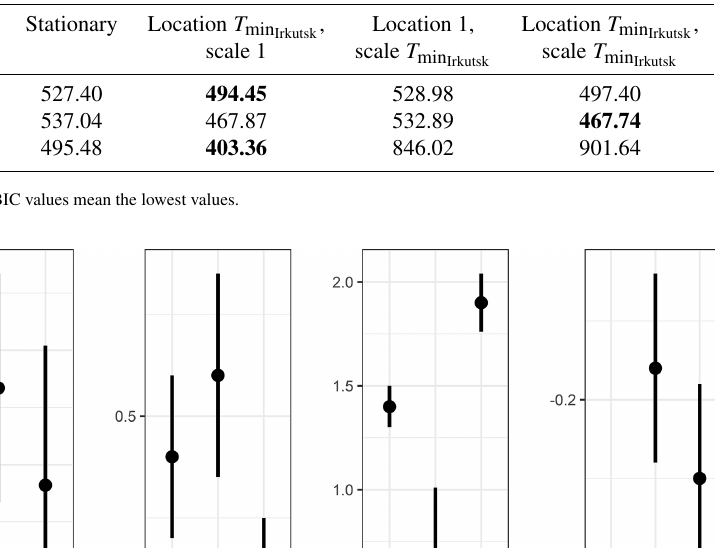
Table 8. BIC values for GEV models using Irkutsk data for three clusters.